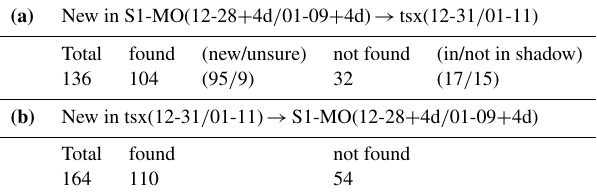
Table 5. (a) Number of new avalanches in the S1 multiorbital change detection image (S1-MO) compared to avalanches in the TSX change detection image. Reverse correspondence in (b)